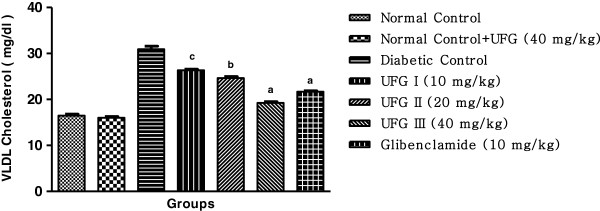
Effect of umbelliferone β-D-galactopyranoside on level of VLDL (very low density lipoprotein) cholesterol at different concentrations on STZ induced diabetic rats, compared to diabetic control group rats; values are mean ± SEM; n = 6;
c
P < 0.05;
b
P < 0.01;
a
P < 0.001; P > 0.05 is considered as non-significant (ns).